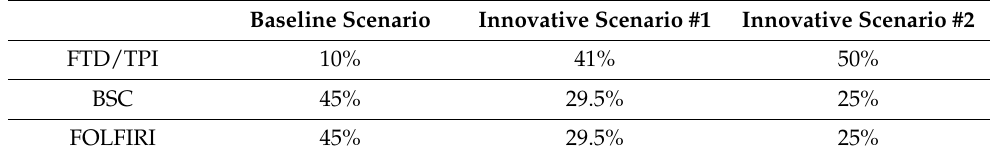
Table 1. Market shares used for the budget impact